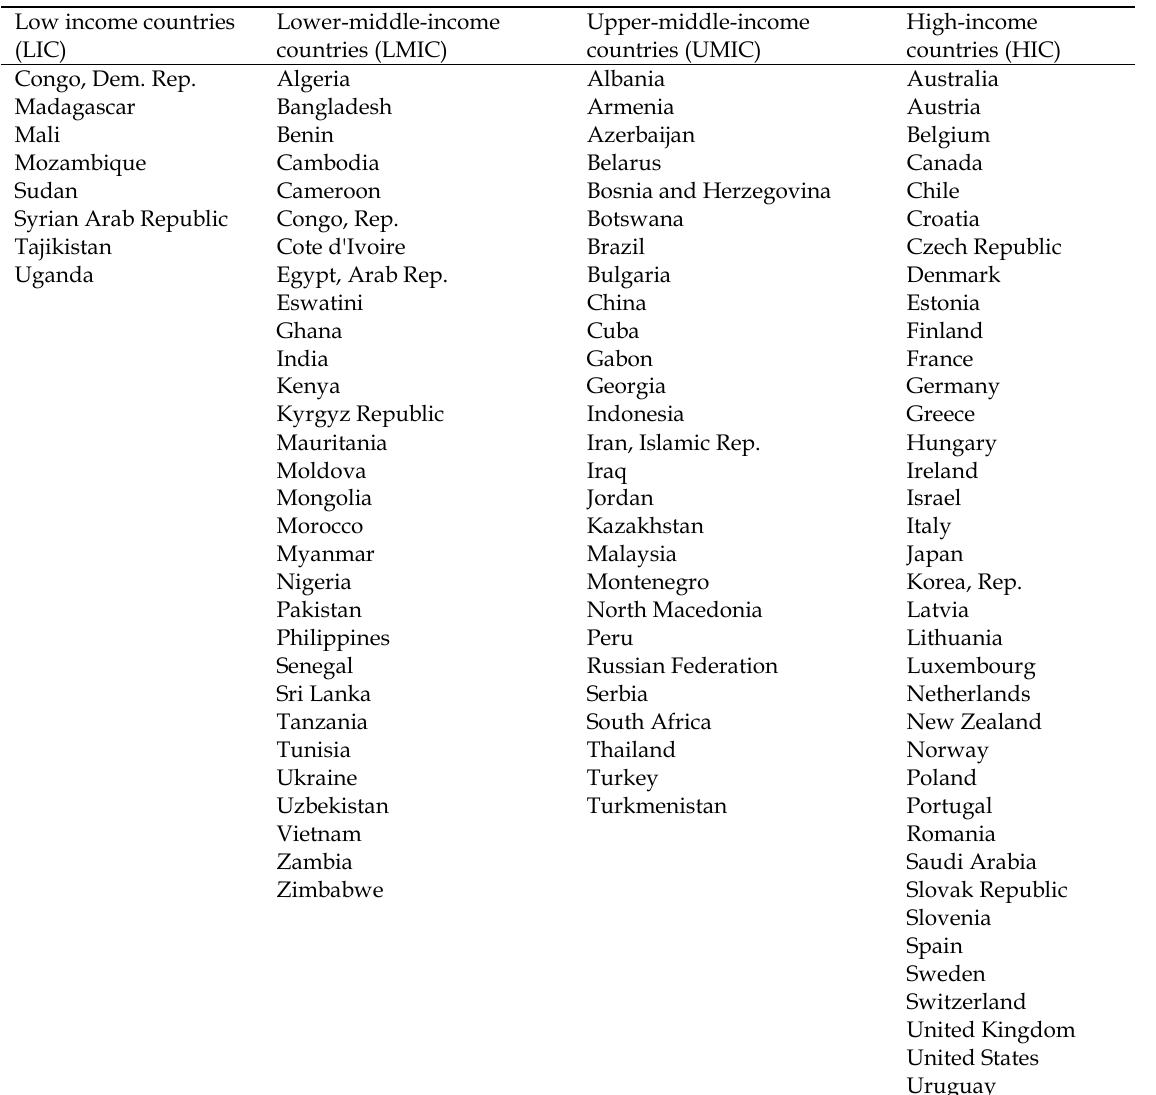
Lower-middle-income countries (LMIC)